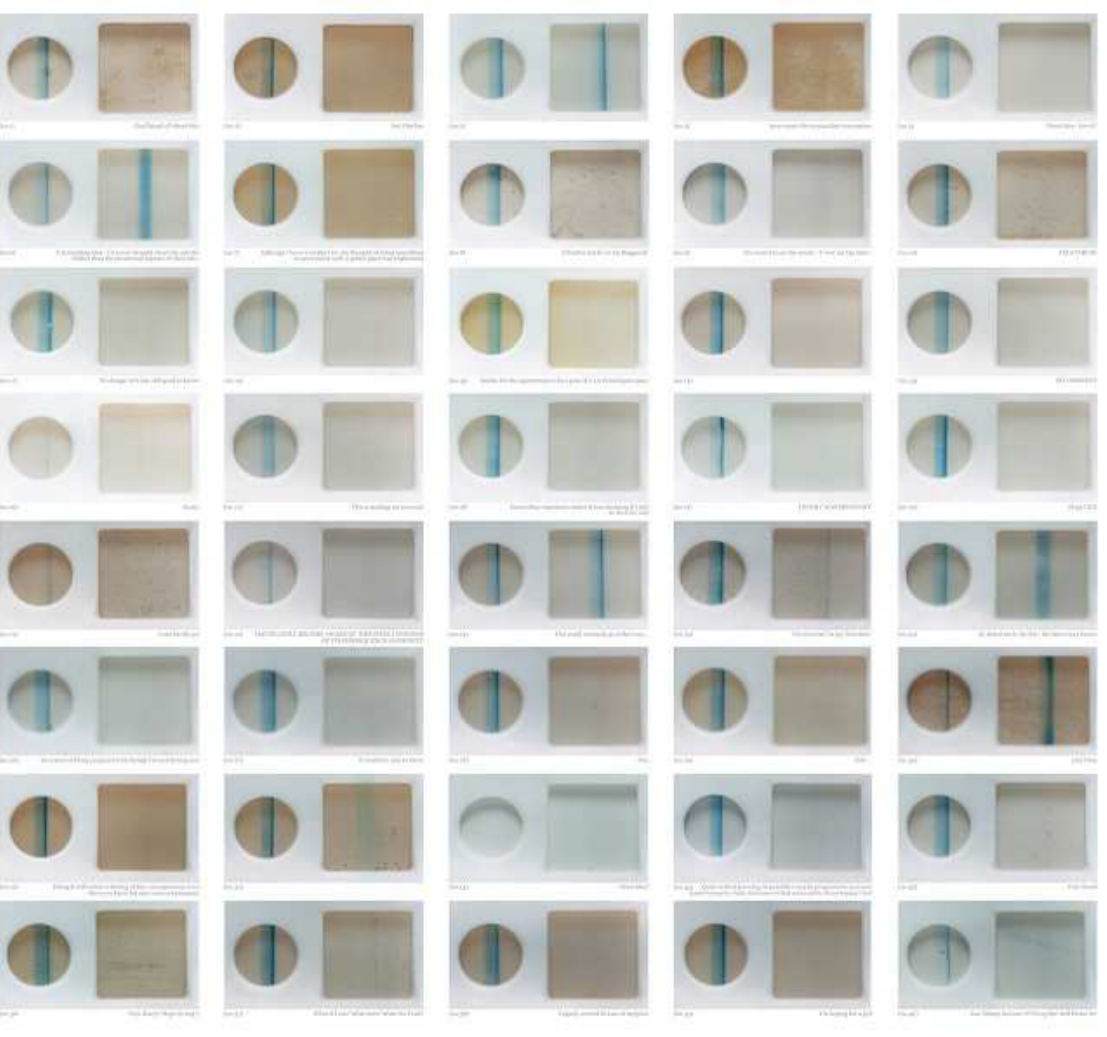
Figure 8: Liv Pennington, 2006, ‘Private View’ Digital C type on Aluminium, 80 x 76 cm, birthrites collection. Reproduced with the permission of the